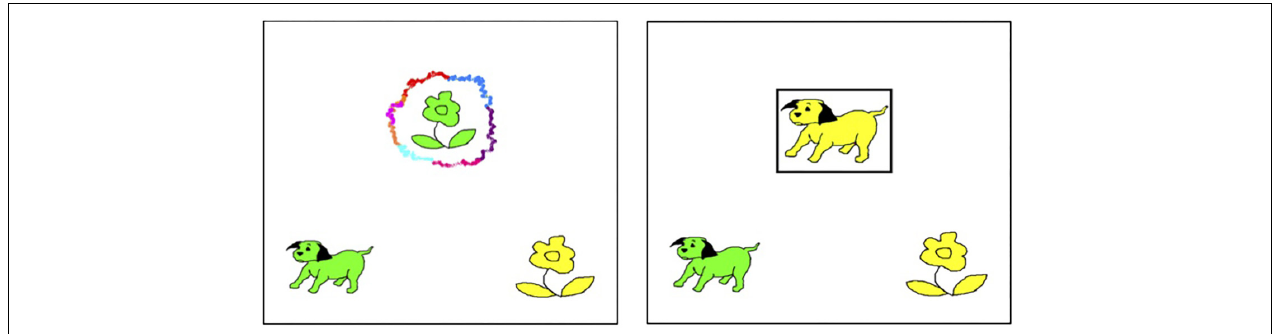
FIGURE 1 | Examples of stimuli ( top : yellow dog or green flower), response pictures ( bottom : green dog and yellow flower), and visual cues (surrounding the stimuli) in each condition of the A-DCCS. Cues were the outlines of a multi-colored cloud and a black square. Children were instructed to pick the response picture that matched the stimulus on either color or shape, depending on the